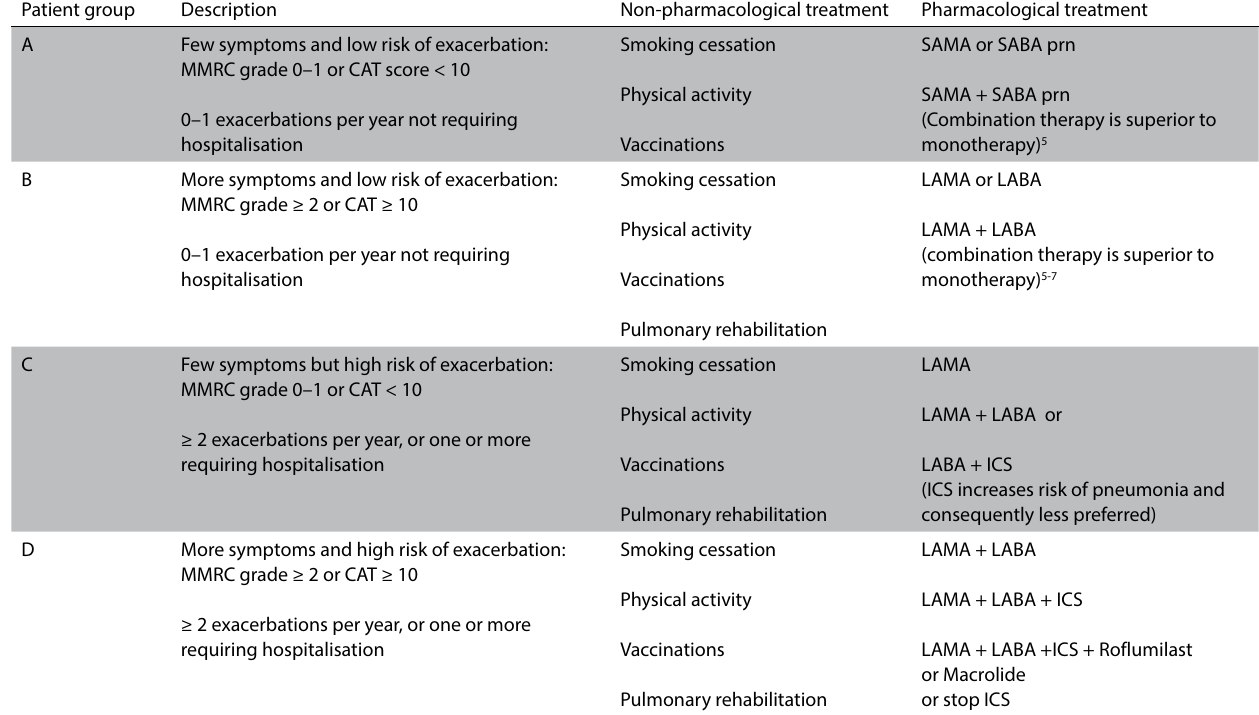
Table 4. Management of COPD based on GOLD grade and exacerbation history Patient group